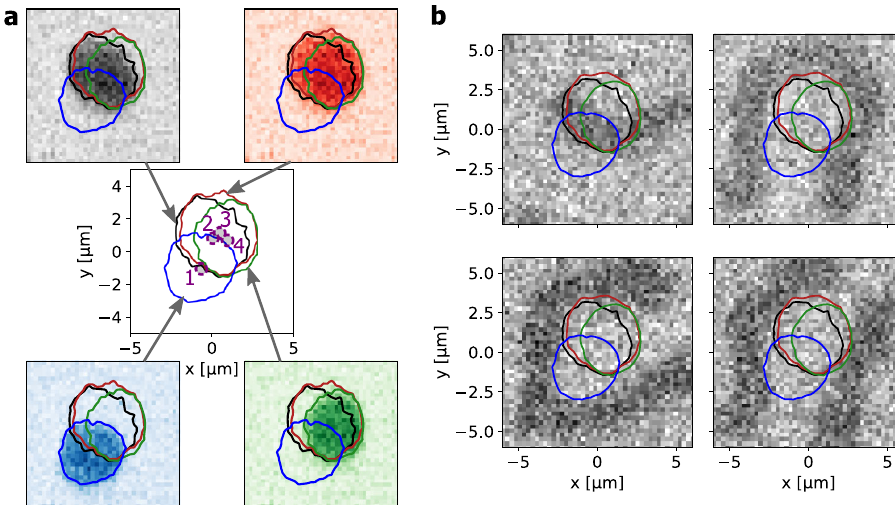
Fig. 4 Pinning of skyrmion boundaries. a The central coordinate frame shows the observed skyrmion boundary positions of the skyrmions at − 35 µ T at pinning sites 1 (in blue), 2 (black), 3 (red) and 4 (green) as introduced in Fig. 2d. The positions of the corresponding skyrmion center coordinates are visualized by the dashed purple circles, which are additionally fi lled in grey for better visibility. The surrounding plots depictthe average intensityfor each pinning site with a color scale matching to the boundary color. b Kerr microscopy images of arbitrary stripe observations in the same sample area. Black corresponds to magnetization pointing out of the plane while white denotes magnetization pointing into the plane. The previously determined skyrmion boundaries are plotted additionally for comparison. The paths of the skyrmion boundaries fi t the domain boundary position of the stripes in signi fi cant